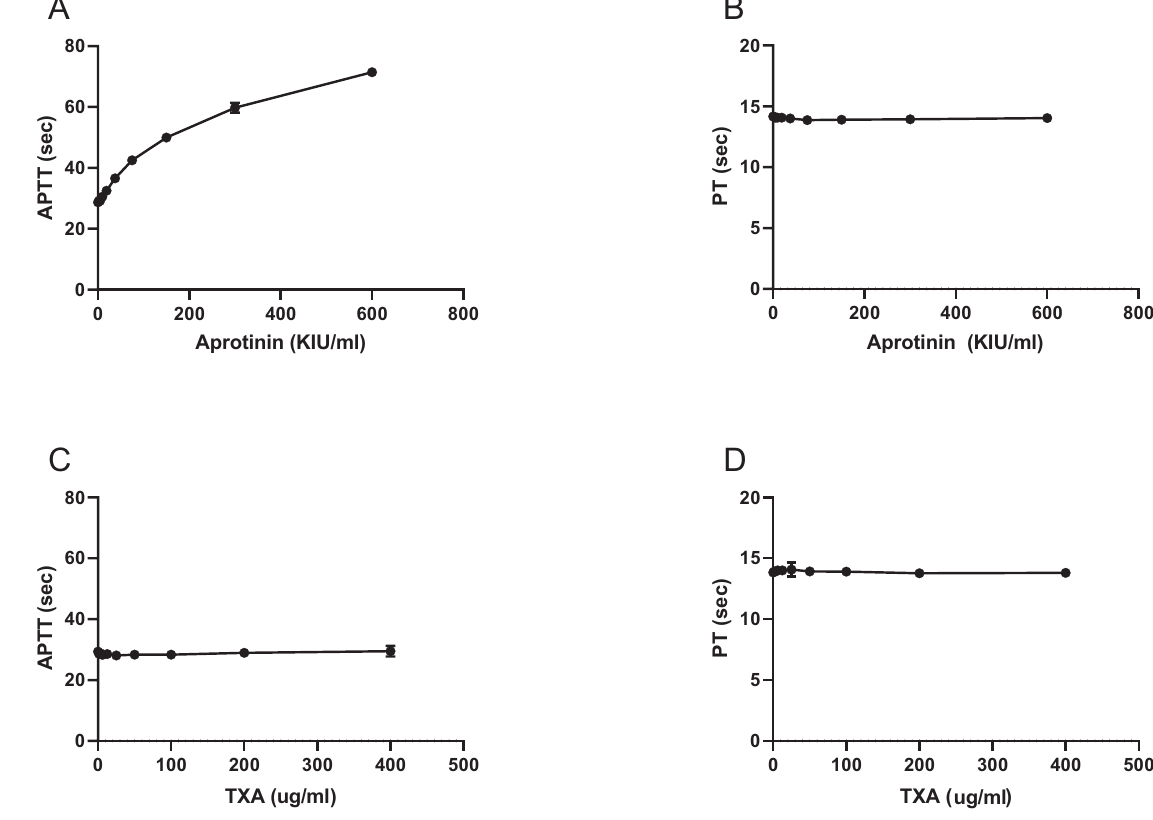
Fig. 2 Effects of aprotinin ( A,B ) and TXA ( C,D ) on the activated partial thromboplastin time (APTT, A,C) and prothrombin time (PT, B,D). Aprotinin and TXA were added to pooled normal plasma in increasing concentrations and APTT and PT assays were performed. Shown are mean values of 3 independent experiments. Error bars indicate standard deviations (but are not visible for the majority of data points as standard deviations were very low).